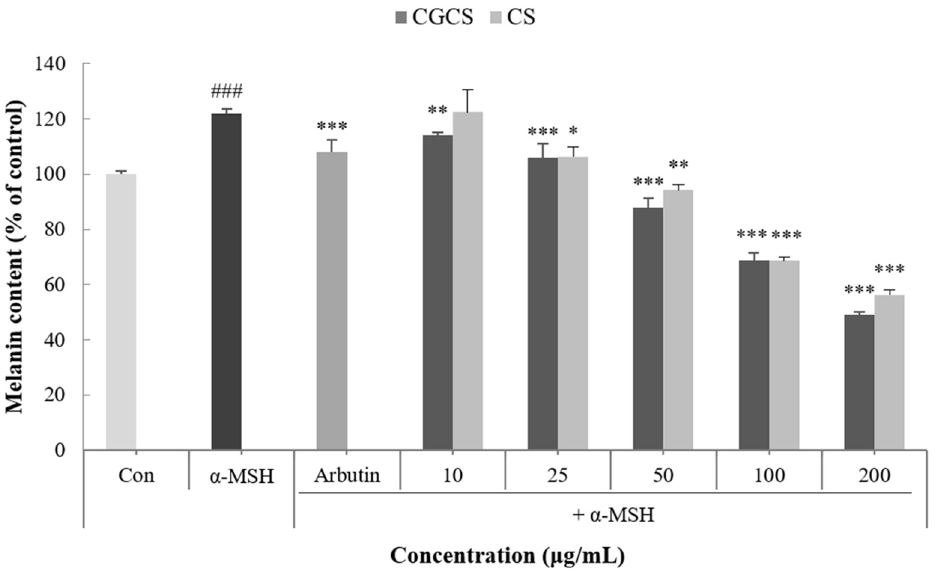
Figure 3. Effect of CGCS extract, CS extract on the melanin content in α‐ MSH ‐ stimulated B16F10 melanoma cells (Ar: Arbutin). Cells were exposed to α‐ MSH (100 nM) alone or with the different samples or arbutin (100 µg/mL) for 72 h. The results are expressed as the mean ± SD from three independent experiments. ### p < 0.001 compared with the control, * p < 0.05, ** p < 0.01, *** p < 0.001 compared with the α‐ MSH.